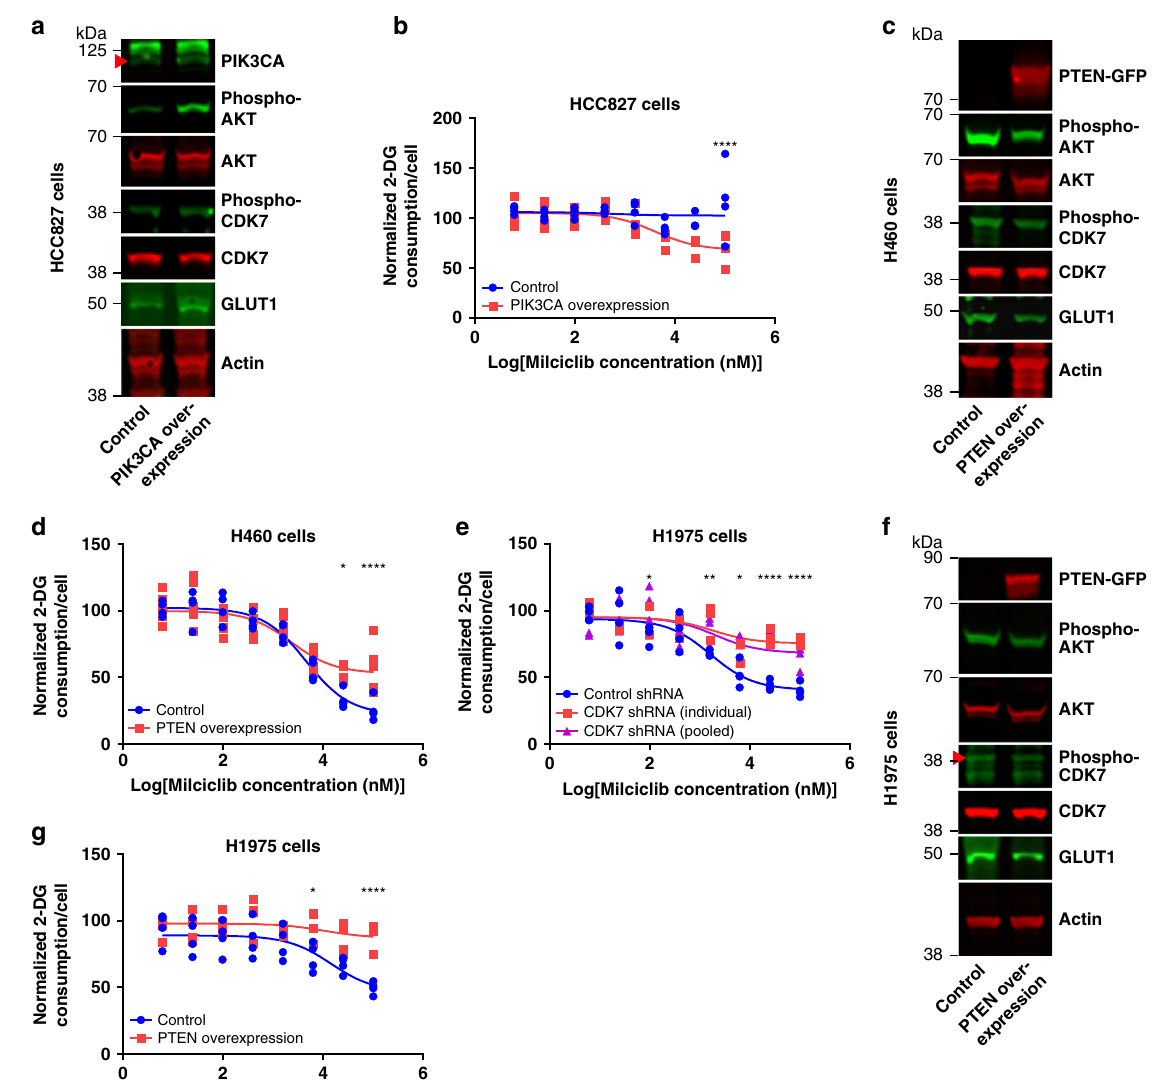
Fig. 6 PIK3CA activates CDK7 to promote glucose consumption. a Immunoblots from HCC827 cells transfected with a control or PIK3CA overexpression plasmid. n = 2. b Glucose consumption dose response curves of HCC827 cells transfected with a control or PIK3CA overexpression plasmid and treated with Milciclib. n = 4. P values determined by a two-way ANOVA test. c Immunoblots from H460 cells transfected with a control or PTEN overexpression plasmid. n = 2. d Glucose consumption dose response curves of H460 cells transfected with a control or PTEN overexpression plasmid and treated with Milciclib. Control: n = 4, PTEN overexpression: n = 6. P values determined by a two-way ANOVA test. e Glucose consumption dose response curves in H1975 cells transfected with control shRNA or shRNA targeted against CDK7 and treated with Milciclib. n = 4 except n = 3 for CDK7 shRNA (individual). P values determined by a two-way ANOVA test. f Immunoblots of lysate from H1975 cells transfected with a control or PTEN overexpression plasmid. n = 2. g Glucose consumption dose response curves of H1975 cells transfected with a control or PTEN overexpression plasmid and treated with Milciclib. n = 4. P values determined by a two-way ANOVA test. * P < 0.05; ** P < 0.01; **** P <